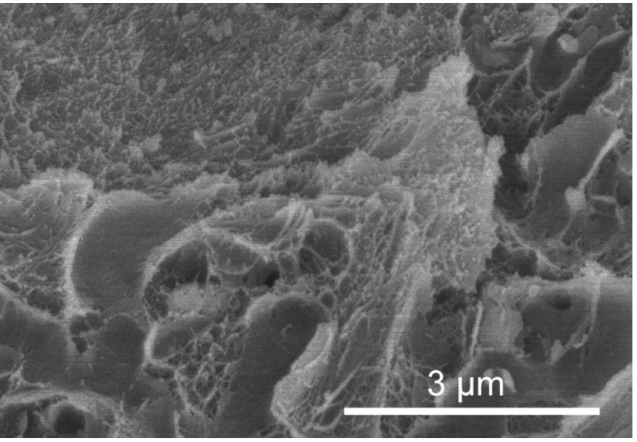
Figure 6. Inner organic tube lining in Spirobranchus giganteus . Horizontal